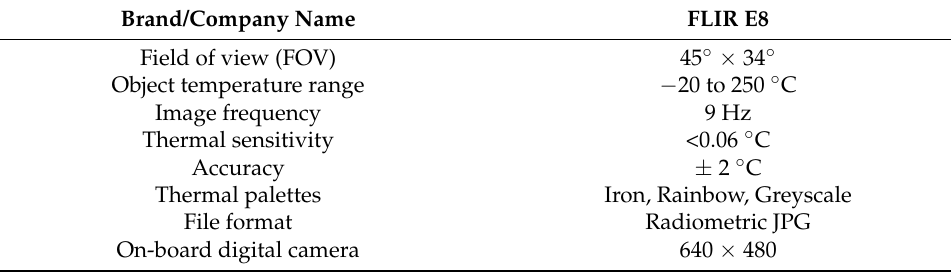
Figure 5. Segmented solar cell sizes to provide a more detailed feature extraction. Table 1. Thermal camera technical